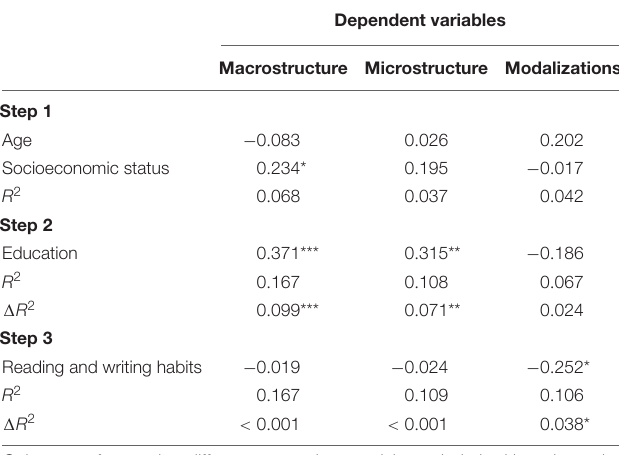
Columns refer to the different regression models and their titles show the dependent variable of the model. (cid:49) R 2 is the incremental increase in the model R 2 that results from the addition of a predictor or set of predictors in a new step of the model.